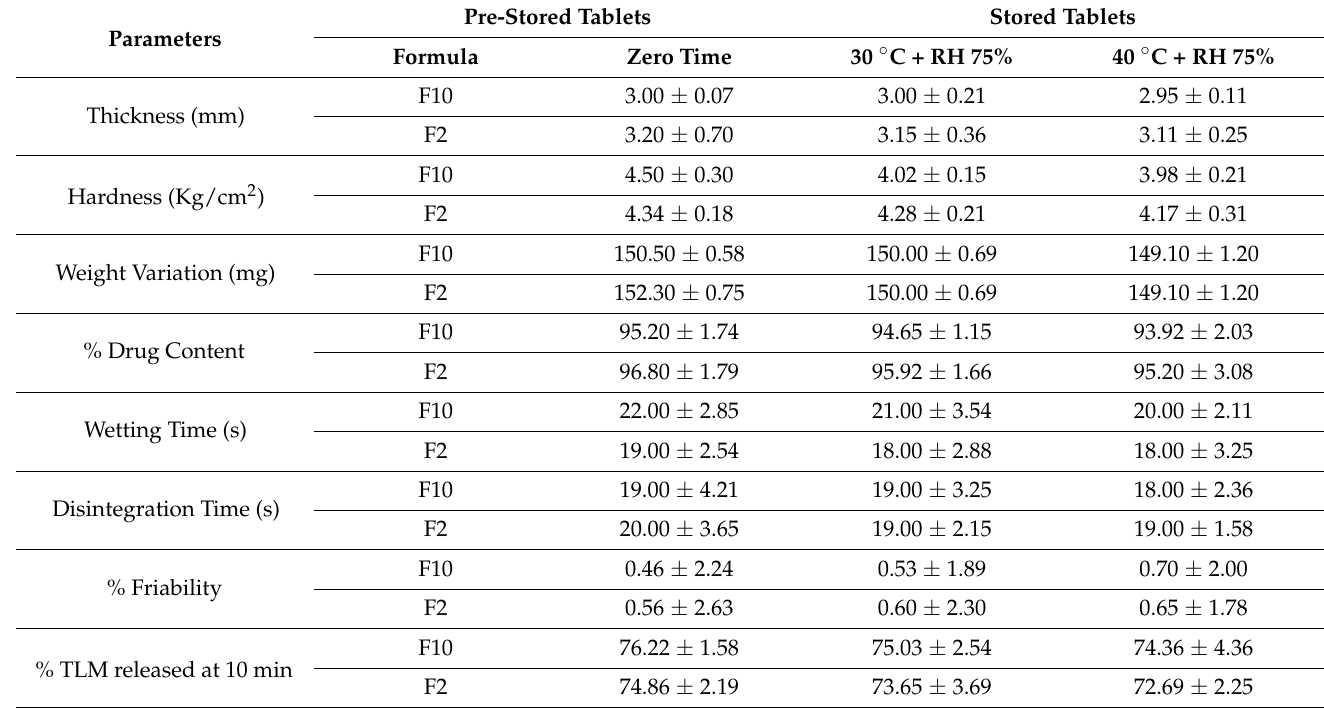
Table 7. Physicochemical properties of TLM-FDTs (F10 and F2) after storage at 30 and 40 ◦ C + RH 75% for three months compared to corresponding pre-stored